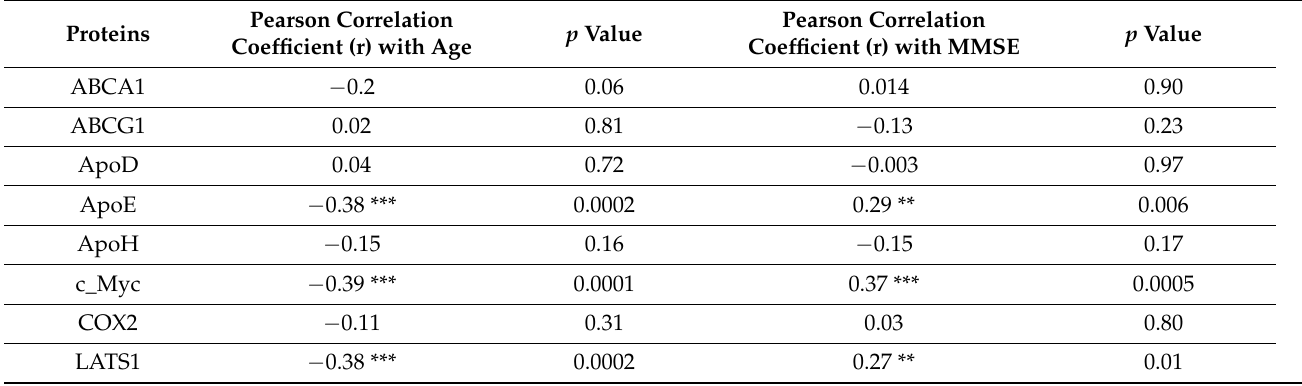
Table 2. The correlation of serum proteins with age or Mini-Mental State Examination (MMSE) scores. The Pearson correlation coefficient (r) and corresponding p -value are presented for each correlation between the specific protein with age or